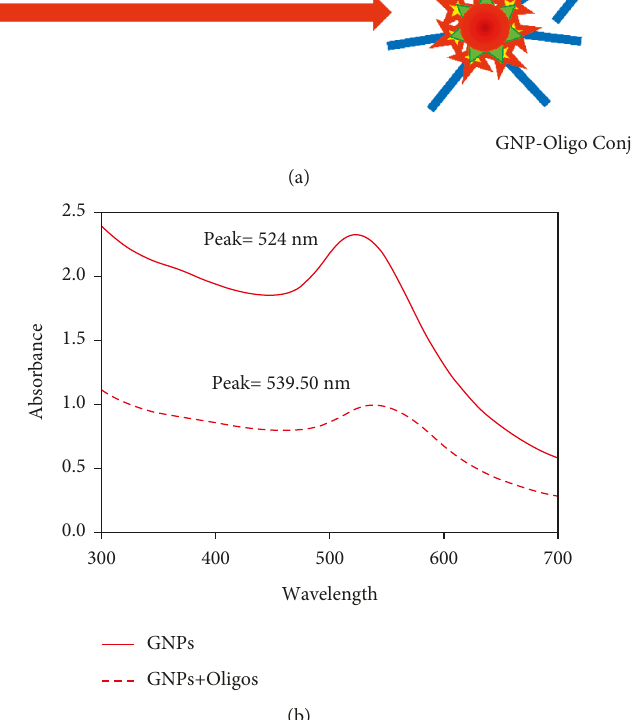
Figure 3: Preparation and characterization of GNP-oligonucleotide conjugate. (a) Schematic representation of conjugation of GNPs and thiolated oligonucleotide probe. (b) Characterization of GNP-oligonucleotide conjugate using the UV-visible spectrophotometer. Red shift in absorbance peak indicates conjugation